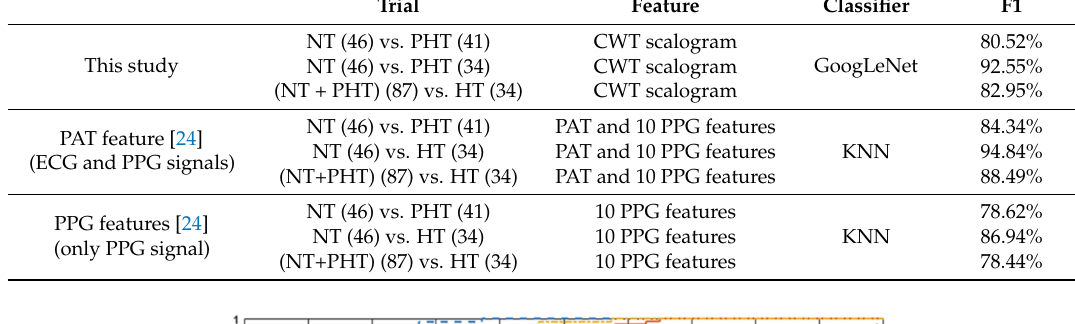
Table 1. Classification performance of the proposed deep learning method and feature-based methods on the same recordings from the MIMIC database [33]. Note, NT, PHT, and HT represent normotension, prehypertension, and hypertension, respectively. PAT stands for pulse arrival time, CWT stands for continuous wavelet transform, KNN stands for k-nearest neighbors.